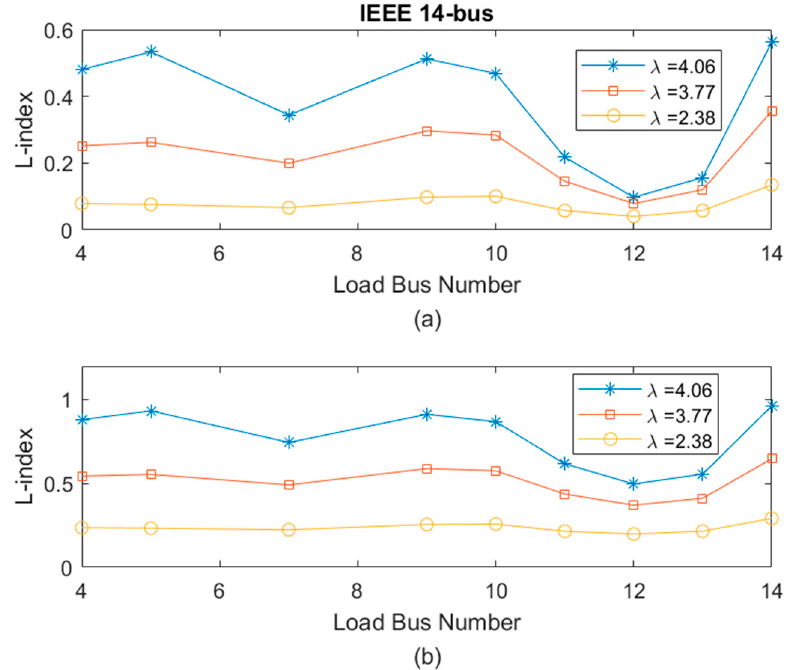
Figure 5. L indices at some load levels for IEEE 14-bus network. ( a ) Results for the RM; ( b ) Results for the proposed method.